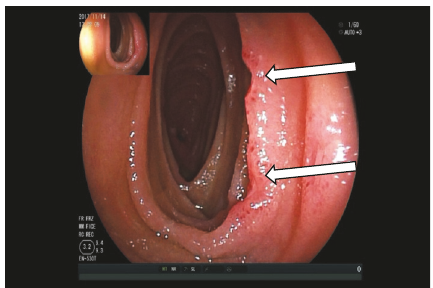
Figure 5: CT scan showing thickened intestinal wall, enlarged lymph nodes.